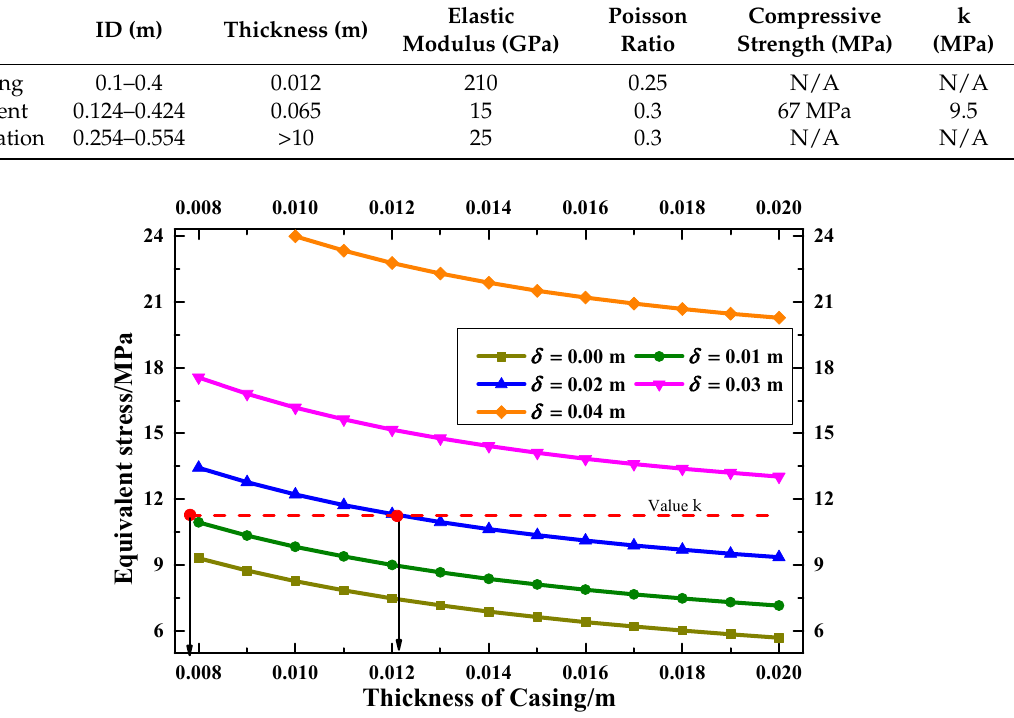
Figure 13. Variation of equivalent stress of the cement sheath with the increase of casing thickness.